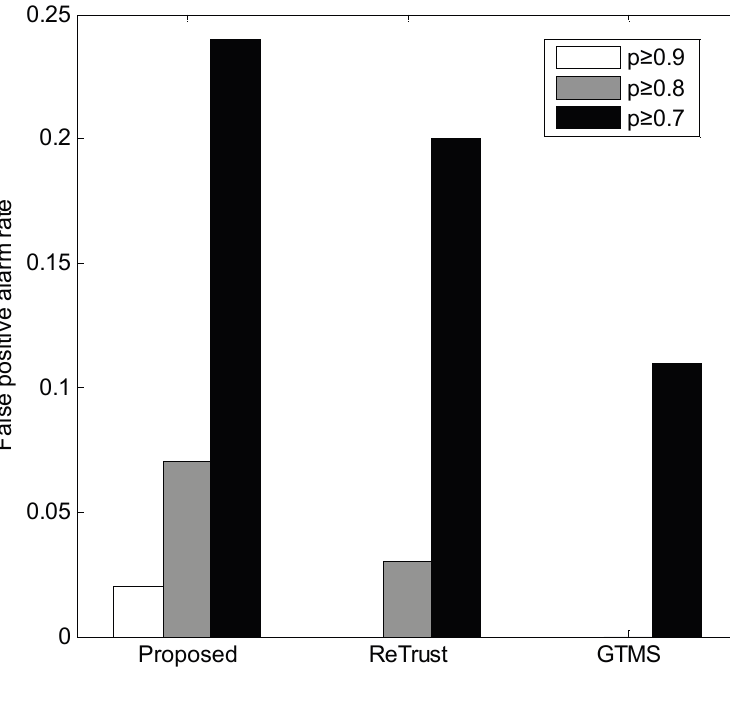
Figure 7. False-positive alarm